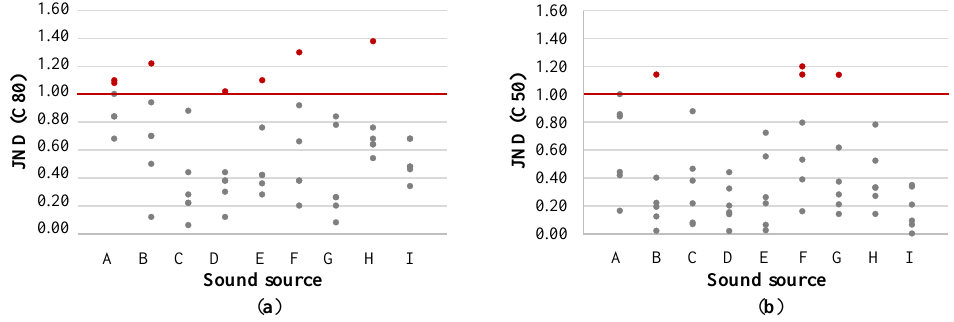
Figure 7. ( a ) Just noticeable difference of C80 (ODEON simulation). ( b ) Just noticeable difference of C50 (ODEON